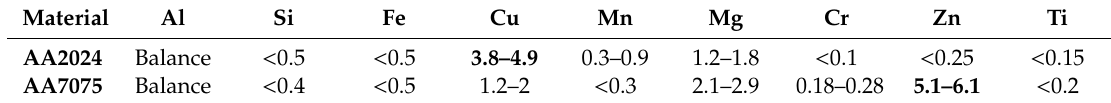
Table 2. Specification of chemical composition for AA2024 and